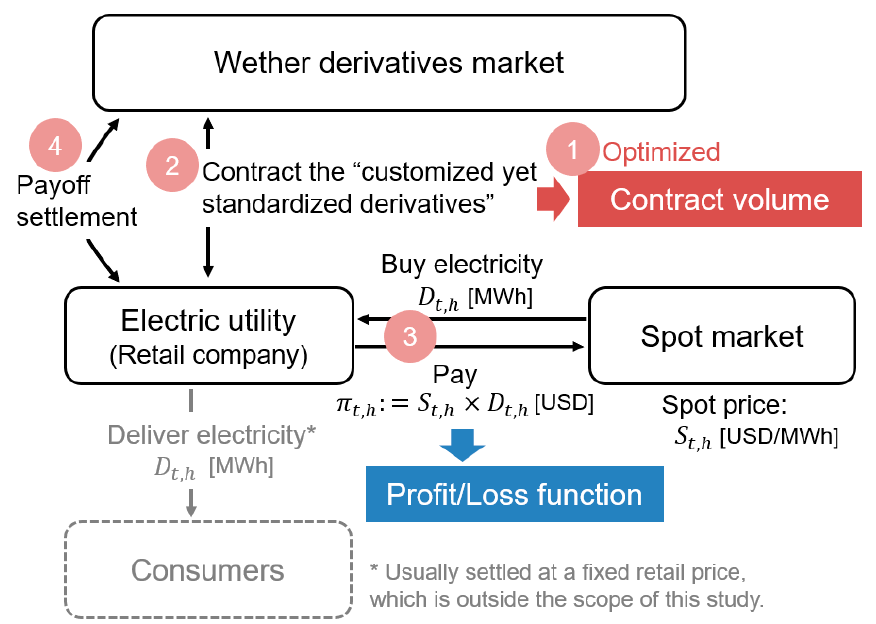
Figure A1. Transaction flowchart of “customized yet standardized derivatives”.